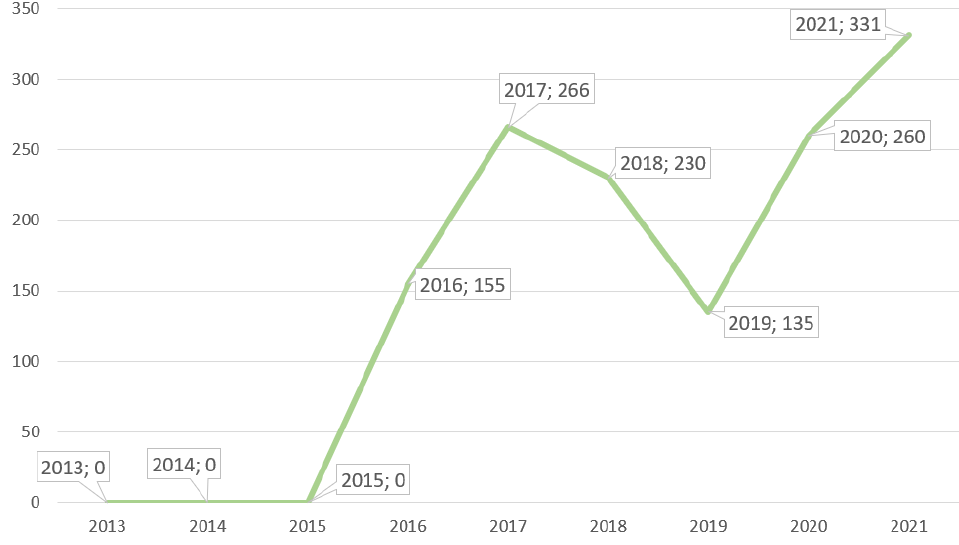
Figure 2. Spanish C. auris cases from 2013 to 2021